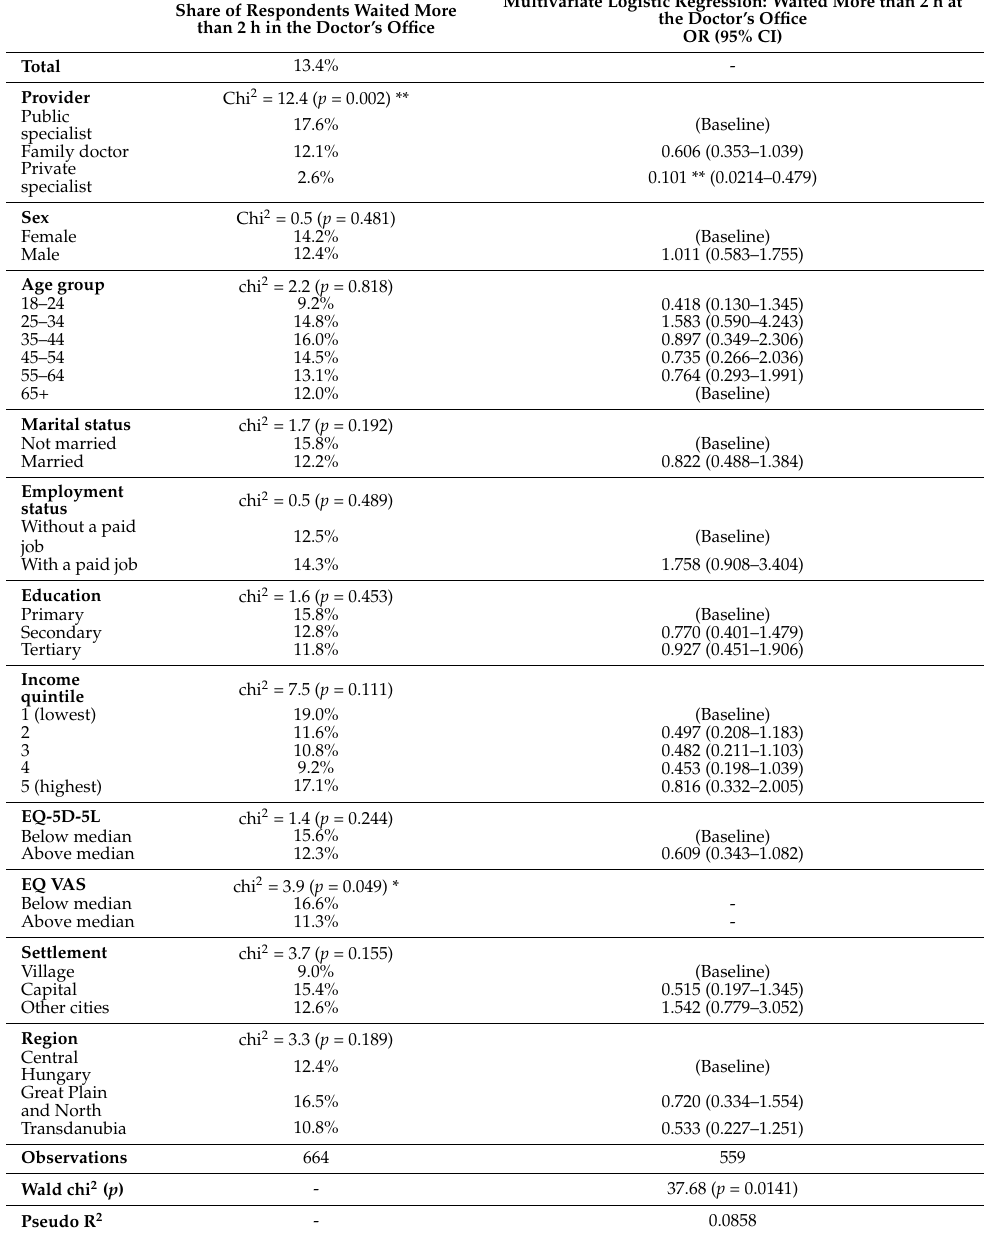
Table 5. Share of respondents who waited more than 2 h in the doctor’s office and multivariate logistic regression